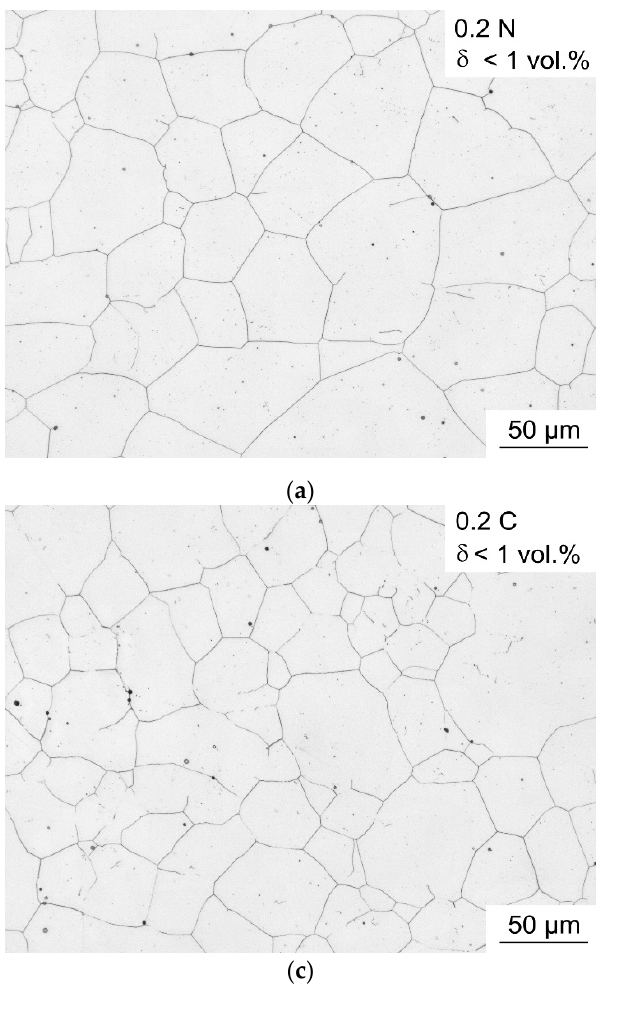
Figure 3. Light optical micrographs of the studied steels: austenite before tensile test ( a ) 0.2N, ( b ) 0.1C-0.1N, and ( c ) 0.2C; and ( d ) deformed microstructure of austenite and strain-induced α ´-martensite of 0.2C steel after tensile test at RT until fracture. The tensile direction in ( d ) is normal to the plane of view.